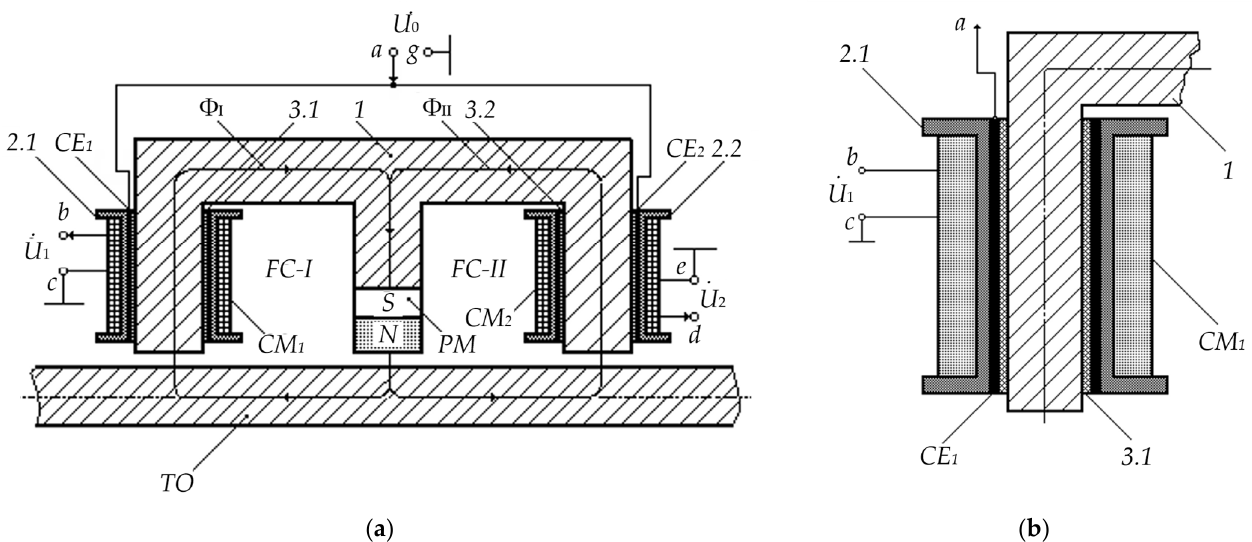
Figure 2. The FS Design Solution Version ( a ) and Increased Fragment of the Left Side of the Cylin- drical Electrode ( b ). Electrode ( b